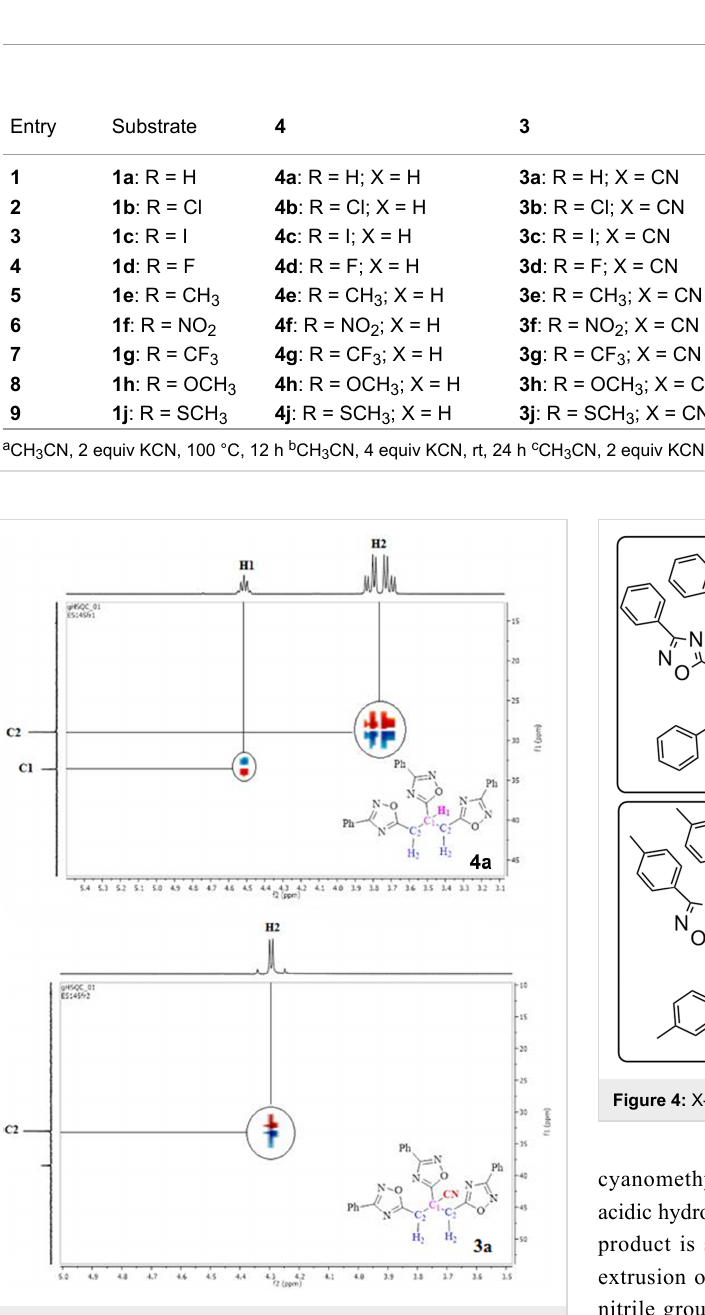
Figure 3: Expanded HSQC spectrum of 4a and 3a .